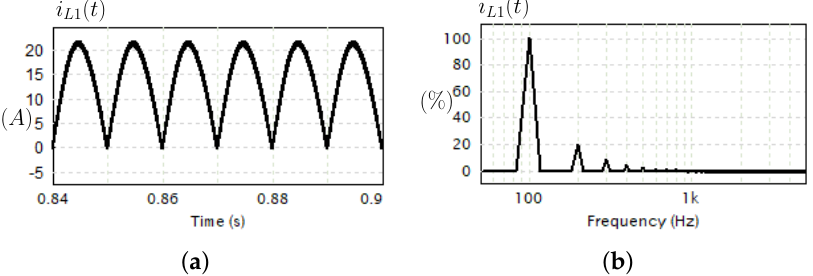
Figure 8. Inductor current i L 1 ( t ) in boost mode with minimum phase condition and its normalized FFT: ( a ) Inductor current waveform i L 1 ( t ) . ( b ) Normalized FFT of inductor current waveform i L 1 ( t ) .